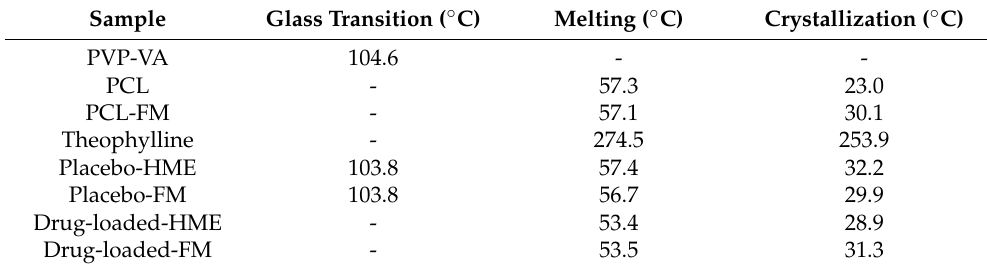
Table 4. The calculated temperature transitions of the samples from the DSC thermographs.